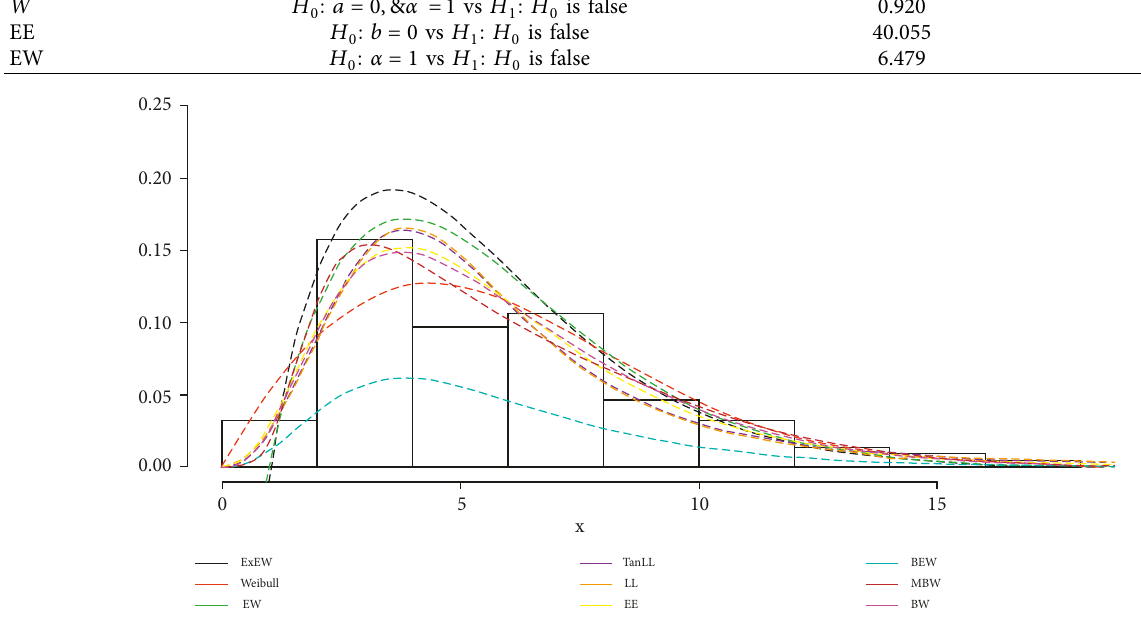
Figure 14: The fitted density shapes of the ExEW distribution and other distributions for COVID-19 fatality rate